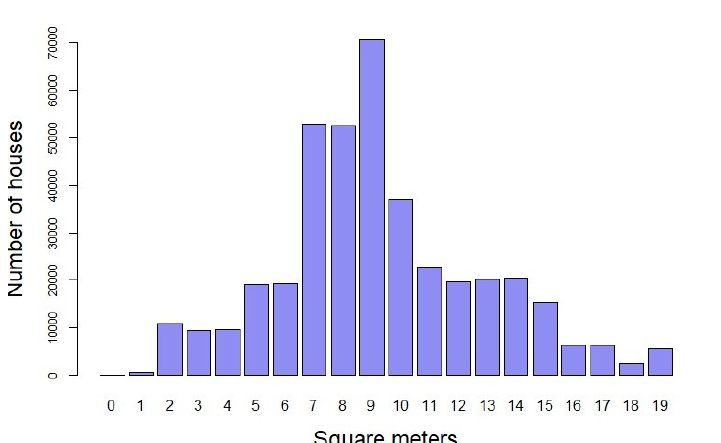
Figure 3. Distribution of number of dwellings according to square metres.